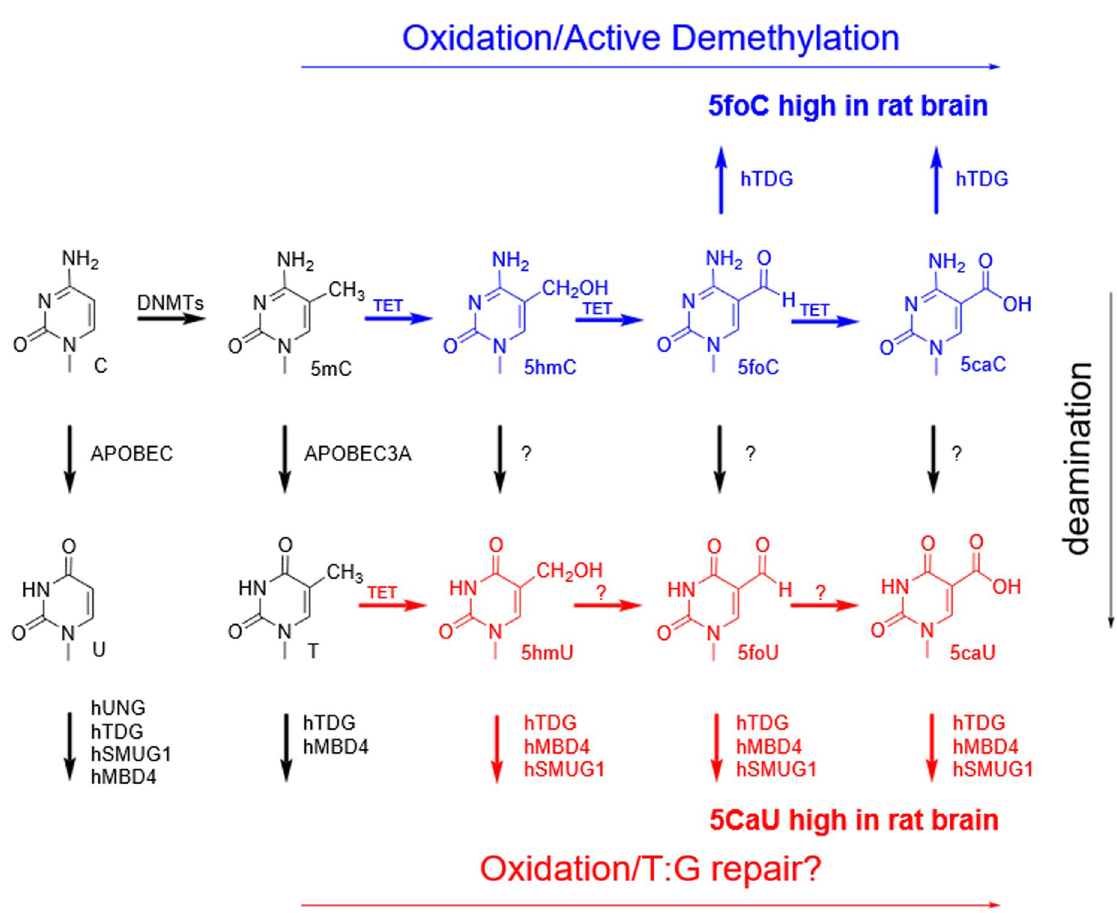
Fig 1. Possible active demethylation pathways resulting from the modification of 5mC. The oxidation of 5mC to 5foC and 5caC, and the removal of 5foC and 5caC by hTDG (blue) have been established. The glycosylase removal of 5hmU, 5foU and 5caU is established here (red). However, the enzymatic conversion of T to 5hmU, 5foU and 5caU (red) remains